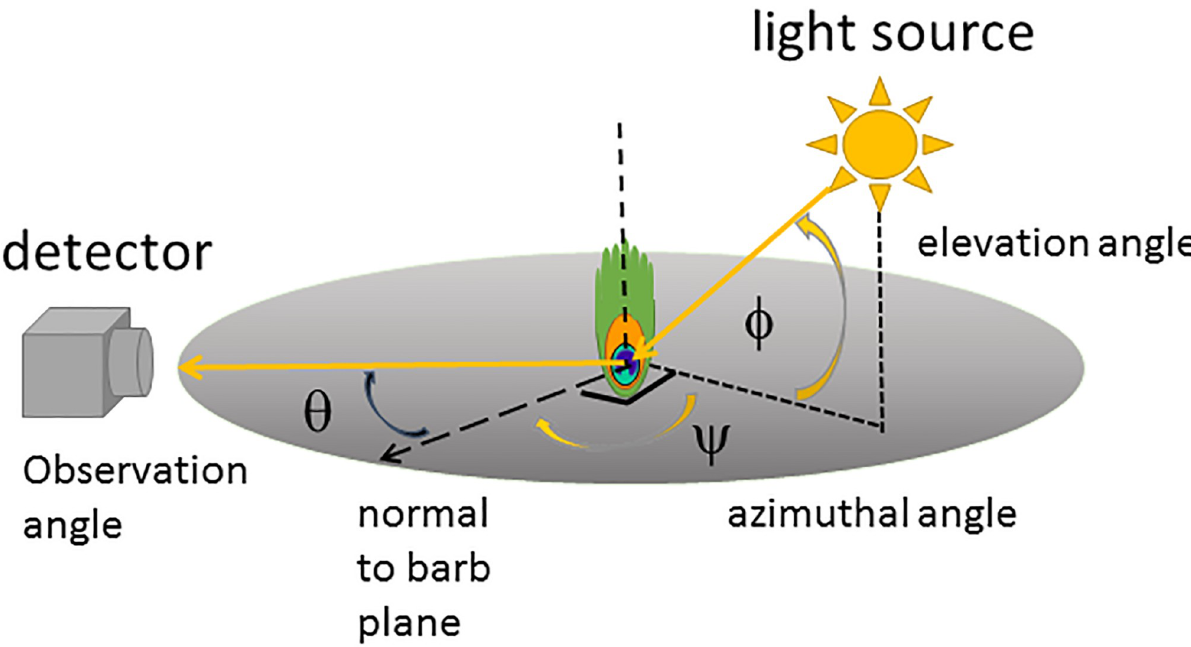
Fig 4. Multispectral imaging geometry showing the angles of observation and